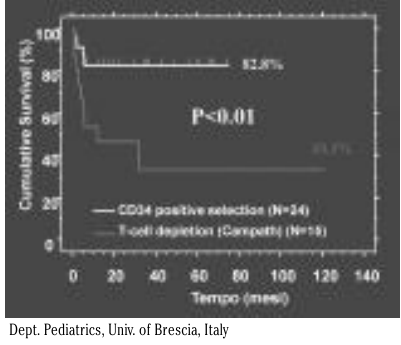
Figura 1. Manipolazione cellulare e soprav- vivenza in bambini affetti da immunodefi- cienza primitiva sottoposti a trapianto